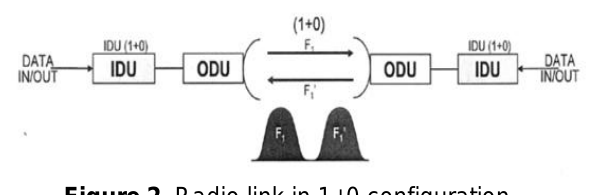
Figure 2. Radio link in 1+0 configuration